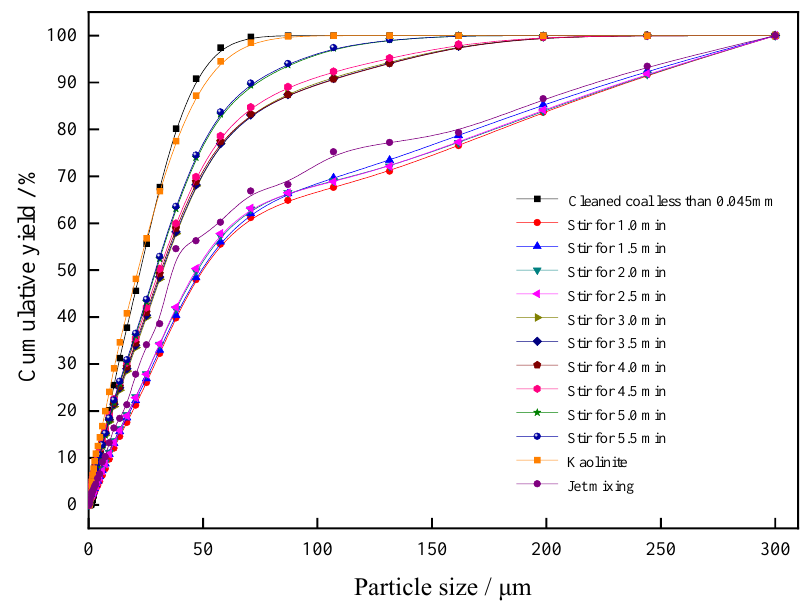
Figure 4. Particle size dissociation of artificially mixed coal sample.